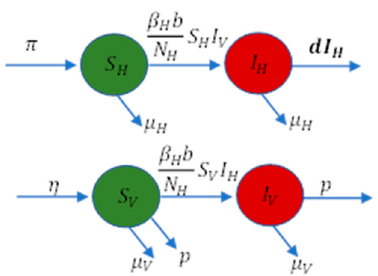
Figure 5. Compartment diagram and flow of disease transmission [19].